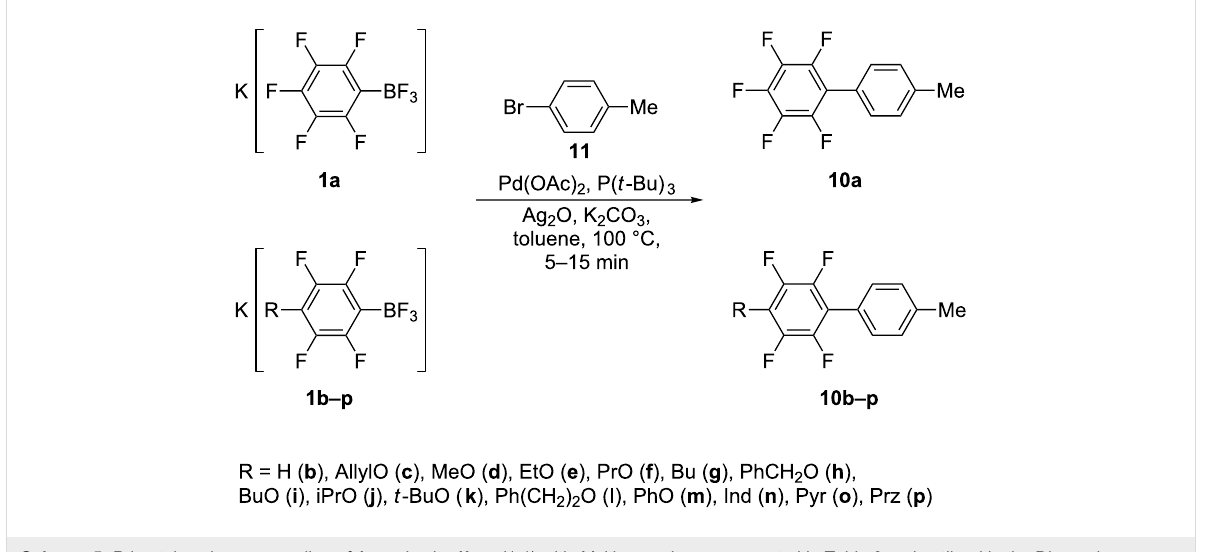
Scheme 5: Pd-catalyzed cross-coupling of 1a and salts 1b–p (1:1) with 11 (the results are presented in Table 3 and outlined in the Discussion section).